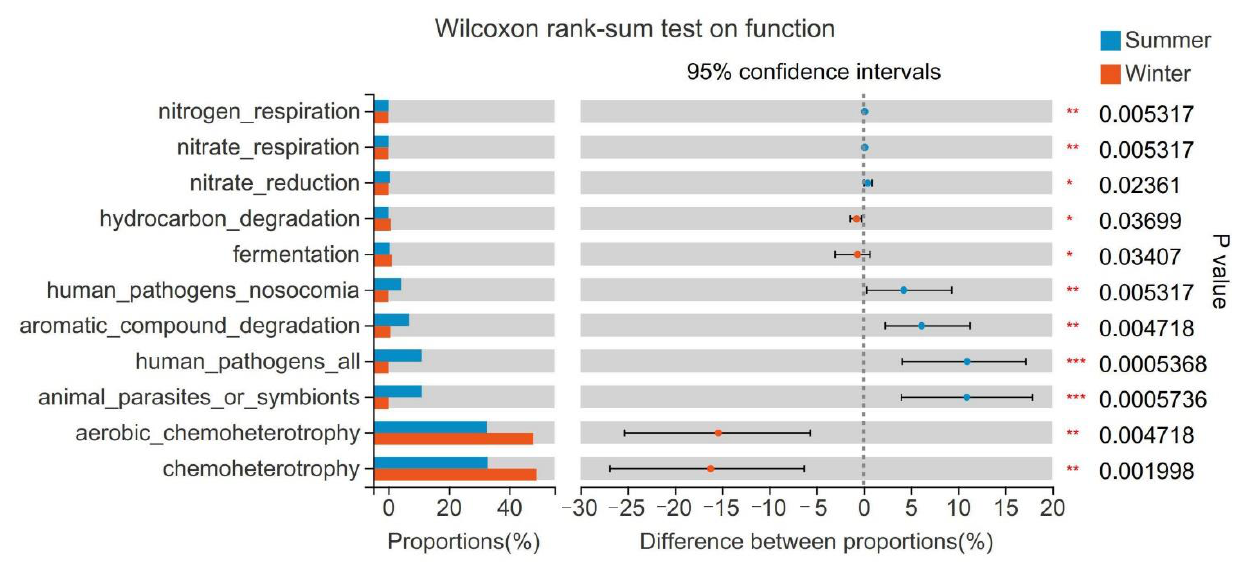
Figure 8. Results of the difference between function properties in two groups of summer and winter. The abscissa represents the name of the function, the ordinate represents the percentage value of the abundance of a function in the sample, and different colours represent different groups. * 0.01 < p ≤ 0.05, ** 0.001 < p ≤ 0.01, *** p ≤ 0.001.